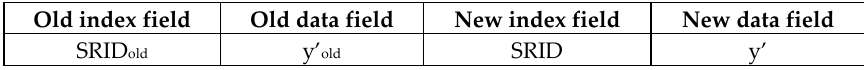
Figure 3. Readers’ index data table in Fan et al.’s scheme.